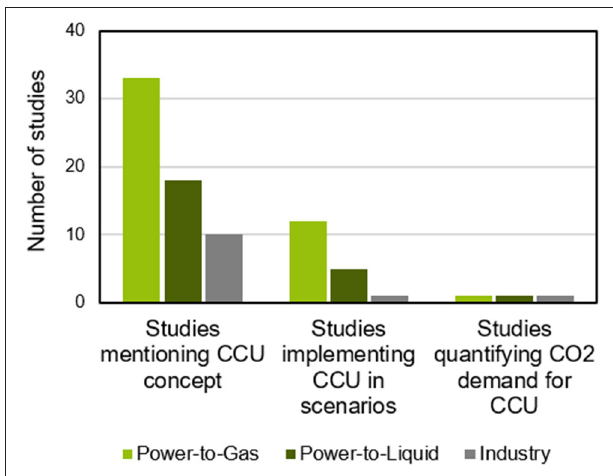
FIGURE 4 | Energy and material related CCU applications in German